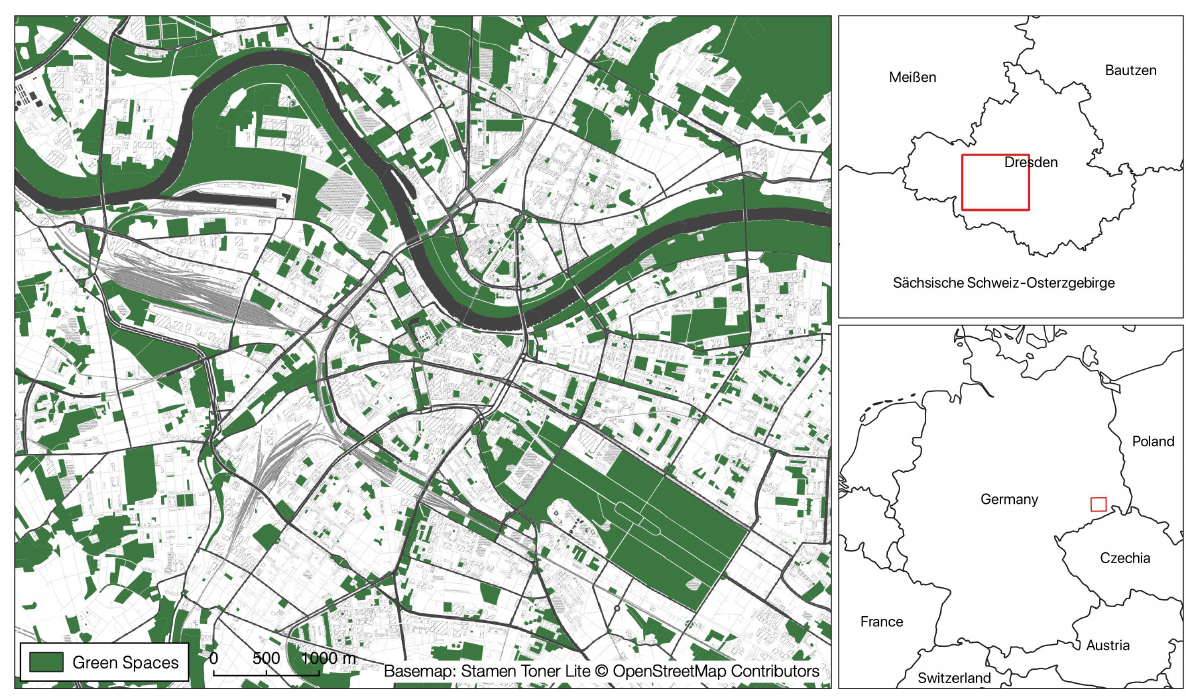
Figure 1. Study area in central Dresden, Germany. Public urban green spaces shown in the map were extracted from municipal